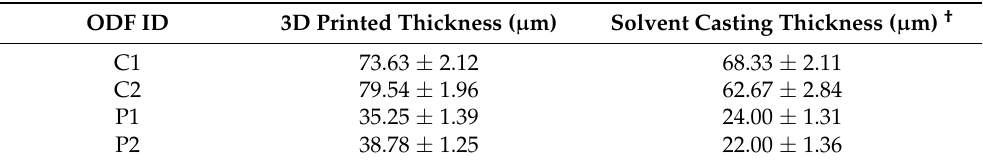
Table 3. Thickness of ODFs produced by 3D printing and solvent casting methodologies with standard deviations ( n =